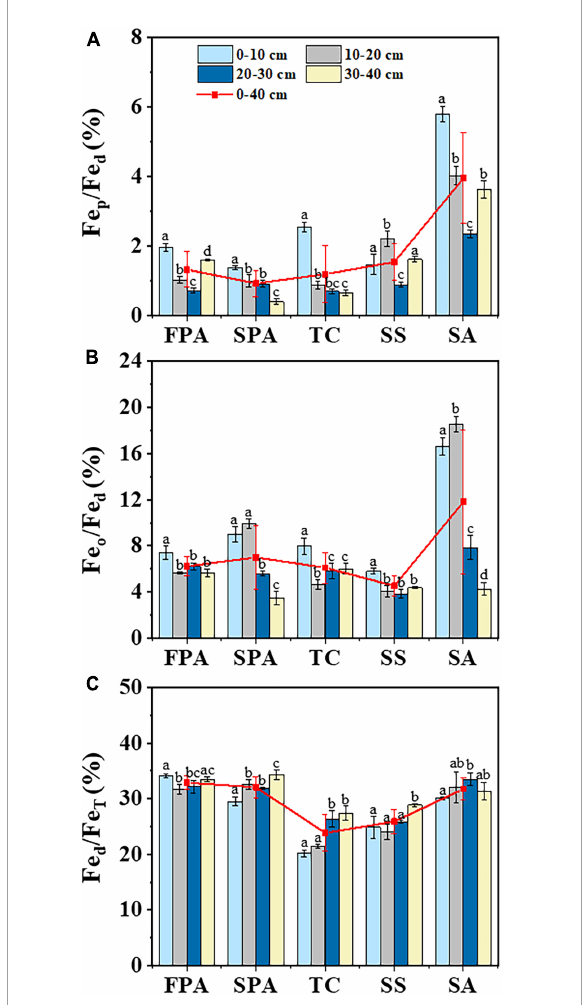
FIGURE4 Distribution characteristics of iron oxide complexation degree (A) , activity degree (B) and free degree (C) in soils of different communities.